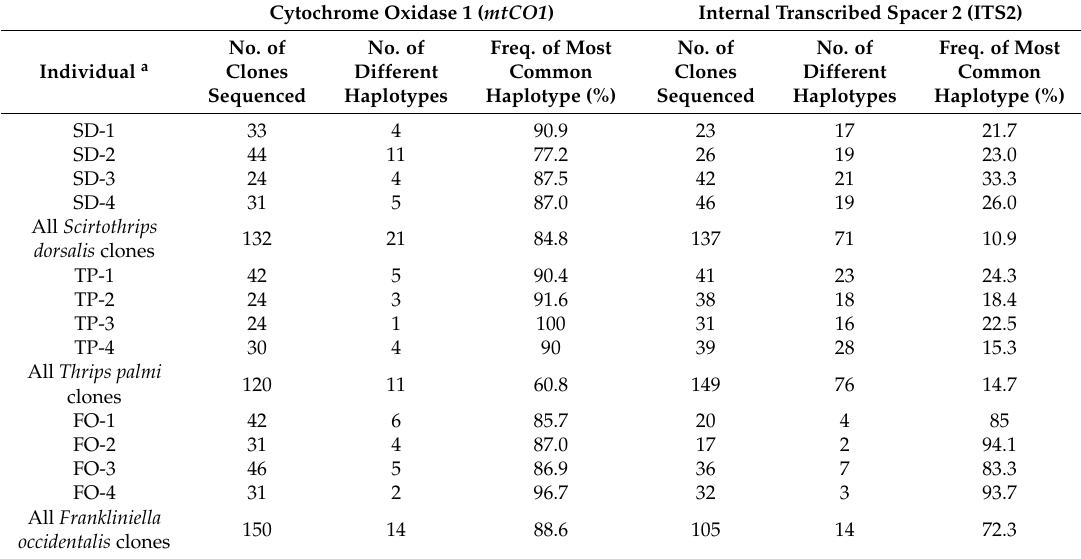
Table 1. Clones sequenced for three thrips